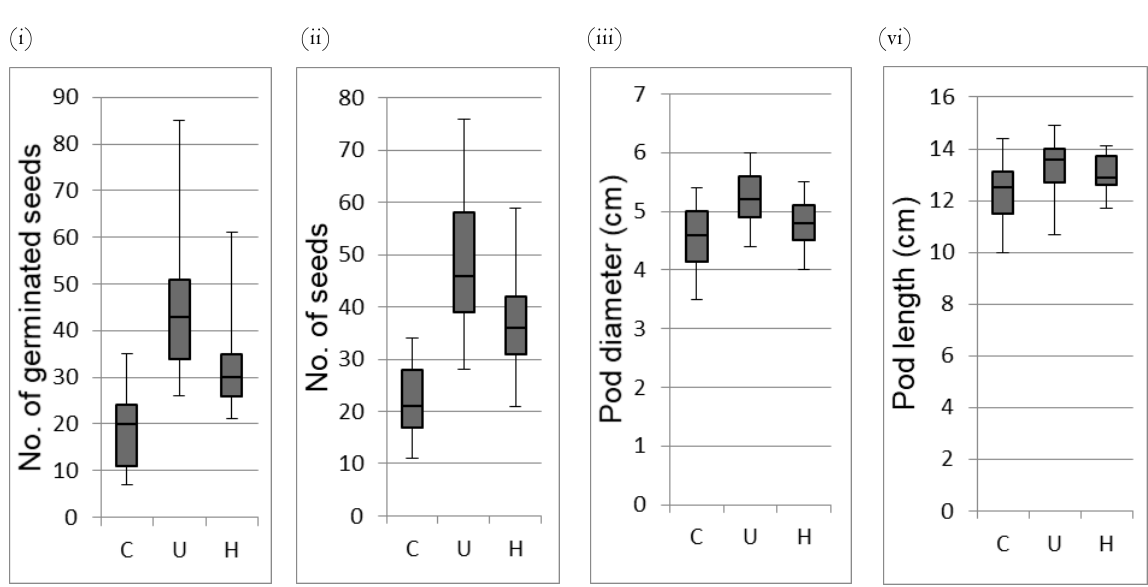
F IGURE 3. Boxplots illustrating (i) pod length and (ii) diameter and the (iii) no. of seeds produced per pod and the (iv) number of germinated seeds collected from okra pods produced from the three pollination trials: covered flowers (C), uncovered/open flowers (U) and hand pollinated flowers (H). Similar letters denote no statistically significant difference (P > 0.05) and dissimilar letters exhibit statistically significant differences (P ≤